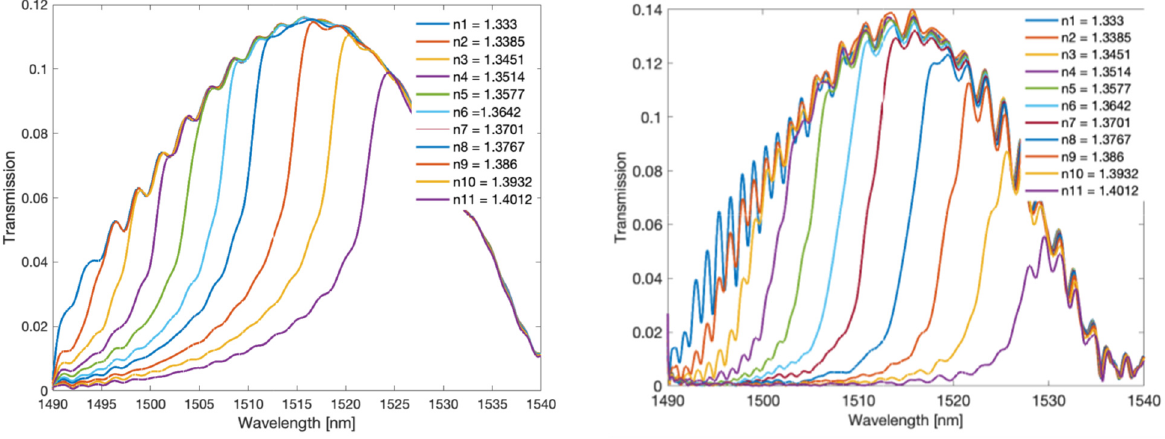
Figure 13. Changing the spectrum of the Hilbert envelope from SRI for band 1 of the TFBG and band 2 for the TCTFBG.